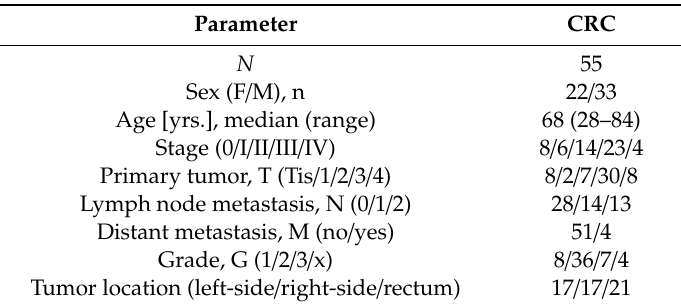
Table 3. Patients’